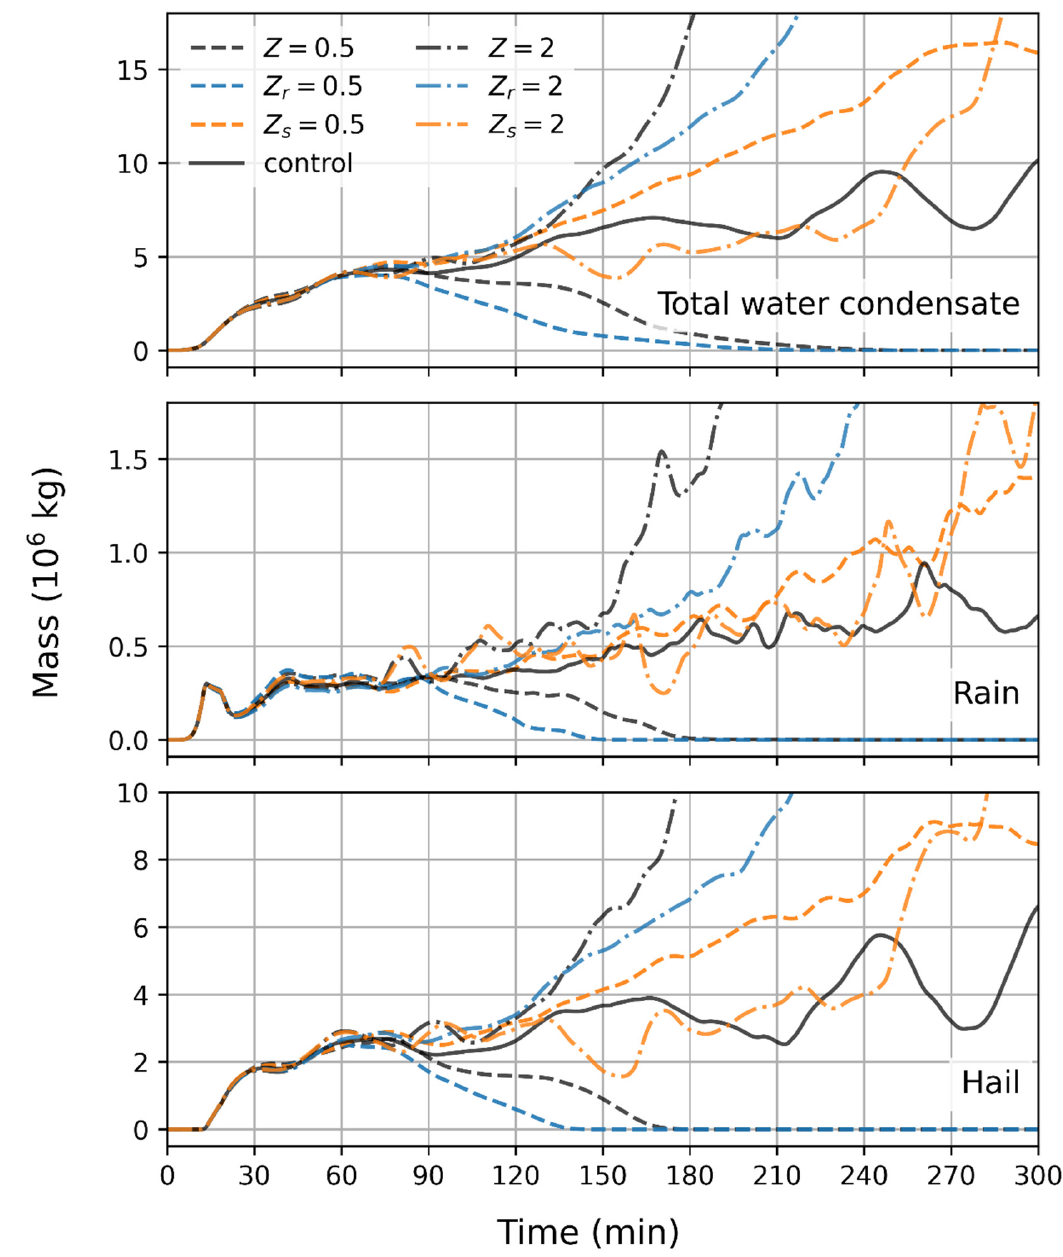
Figure 4. The time evolution of the mass of total water condensate ( upper ), rain ( middle ), and hail ( lower ) in the entire domain. In each panel, the experiments with reduced ventilation are shown in dashed curves, whereas the enhanced cases are in dot-dashed curves. Black is for altering all three species equally, blue for just rain, and orange for just snow and hail. The control case is shown as a black, solid curve. Note that the scales of the vertical axis are different in different panels.